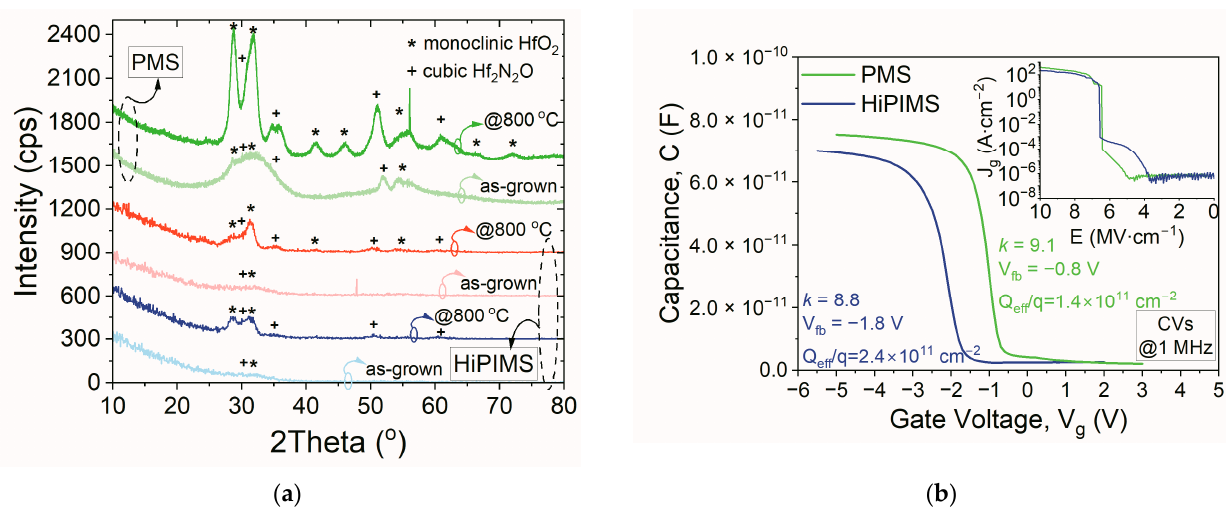
Figure 9. Comparison of GIXRD patterns of dielectric thin films (as-grown and annealed at 800 ◦ C) ( a ) and C-V characteristics of MOS devices with HfO x N y films fabricated using PMS and HiPIMS processes and annealed at 800 ◦ C ( b ); the inset to ( b ) shows the leakage current density vs. breakdown electric field intensity (E br ) of MOS structures.